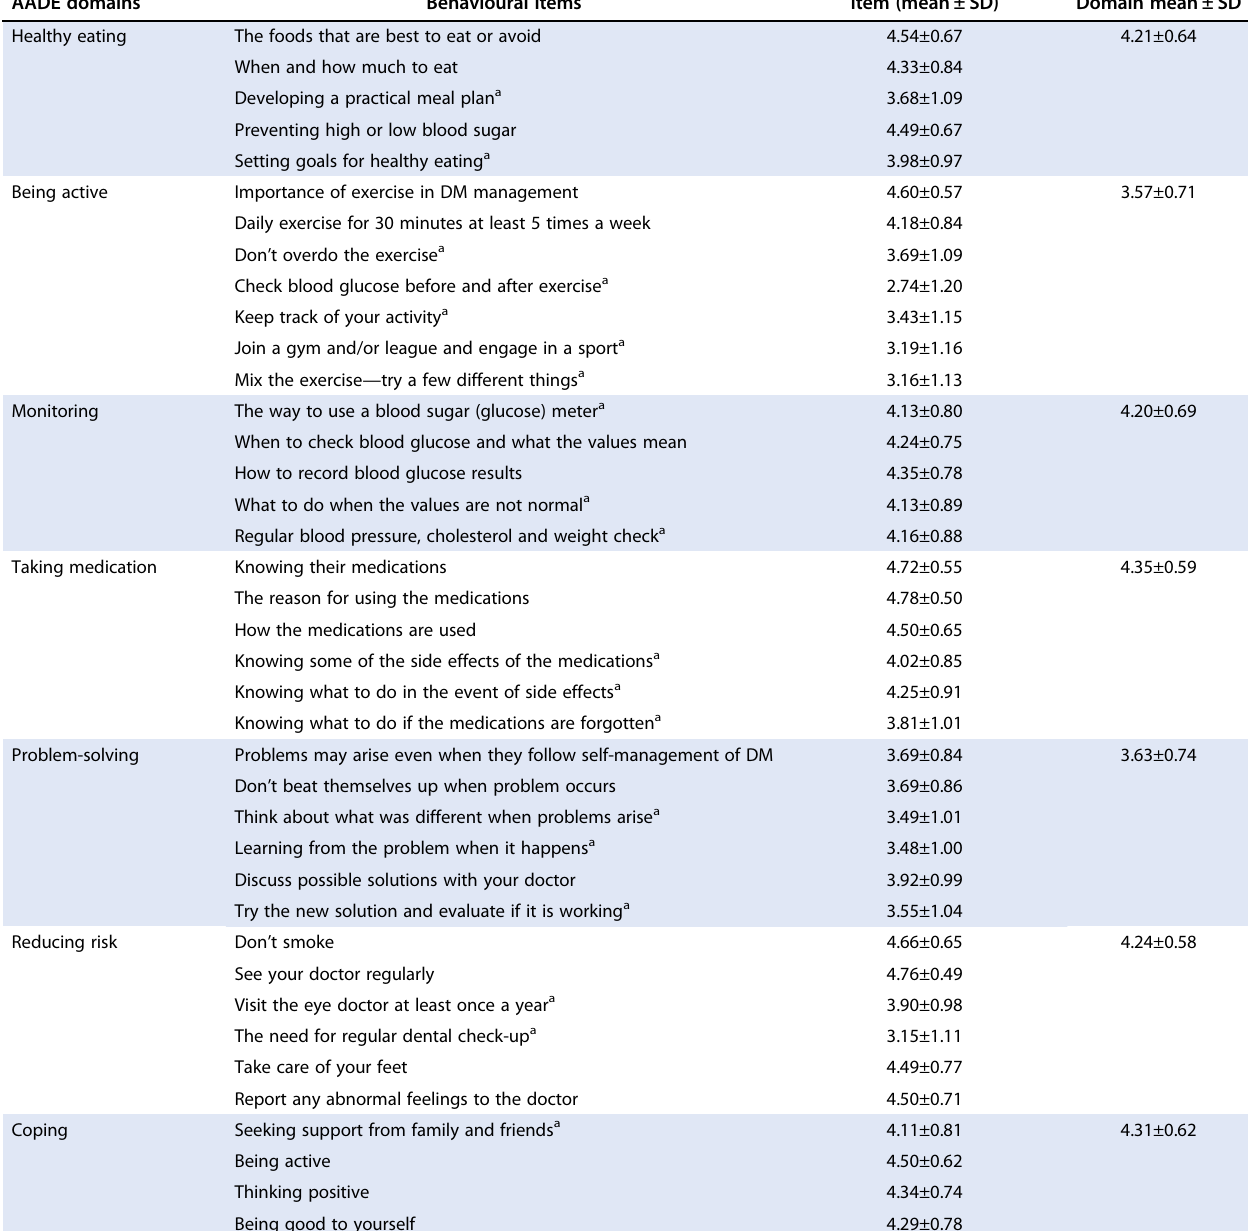
Table 3: Item mean and domain mean of the respondents AADE